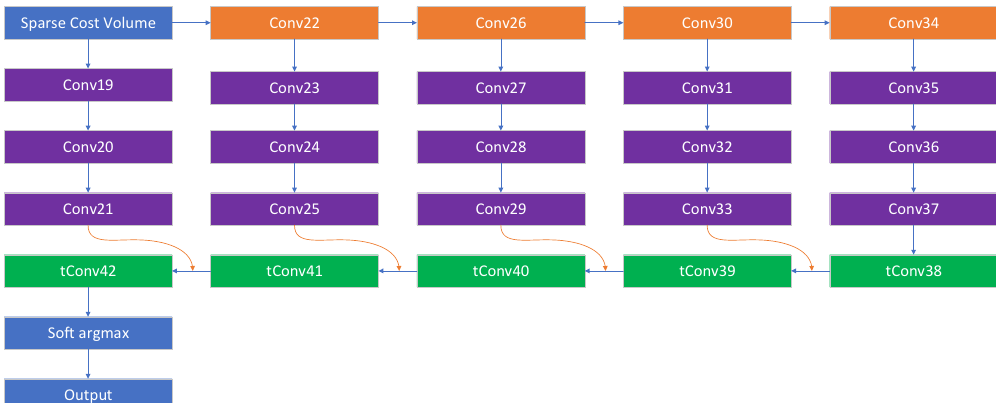
Figure 4. Structure of our Similarity Evaluation Network. Orange blocks represent down-sampling layers. Green blocks represent up-sampling layers. Purple blocks represent similarity evaluation branches. Orange links represent residual